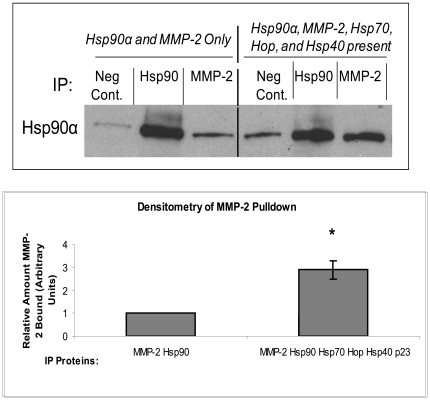
The presence of Hsp70, Hop, Hsp40, and p23 increase the interaction between Hsp90α and MMP-2.Using recombinant proteins, two co-immunoprecipitations were performed, one with Hsp90α and MMP-2 alone and one with Hsp90α, MMP-2, Hsp70, Hop, Hsp40, and p23 present using the same quantities as in Fig. 2. Hsp90α and MMP-2 primary antibody were used to pull down Hsp90α and then the resulting proteins were run on an SDS-PAGE and blotted for Hsp90α. The bands were then subject to densitometry to determine the relative interaction between Hsp90α and MMP-2 with and without the presence of the co-chaperones. Experiments were repeated three times. P-value<0.001.